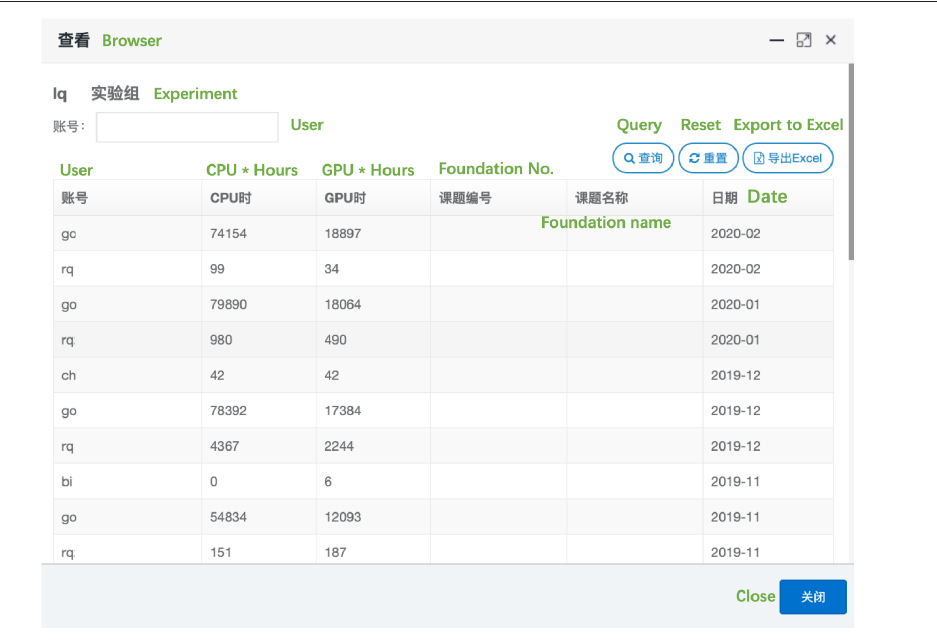
Figure 3: Monthly invoices on the service system web